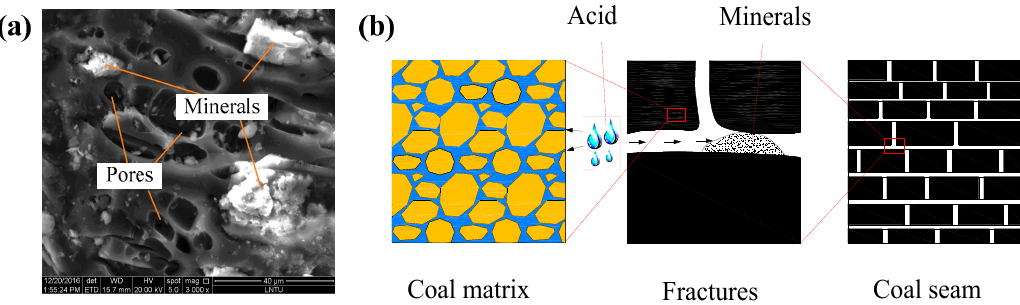
Figure 1. Minerals and acid in coal seam: ( a ) minerals, and ( b ) reaction between acid and mineral. The principles of chemical reactions between different minerals and acid types vary. According to the type of reaction between minerals and injected acid in coal seam, acid fracturing can be divided